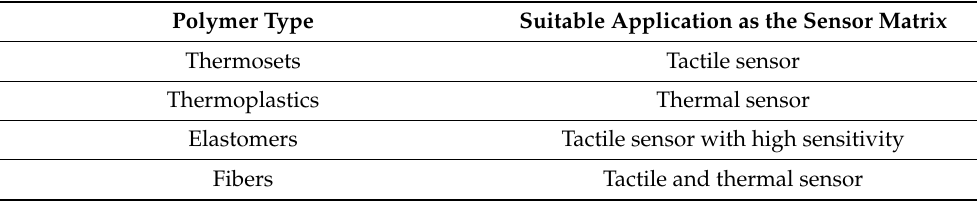
Table 4. Suitable application of different polymers as the sensor matrix.